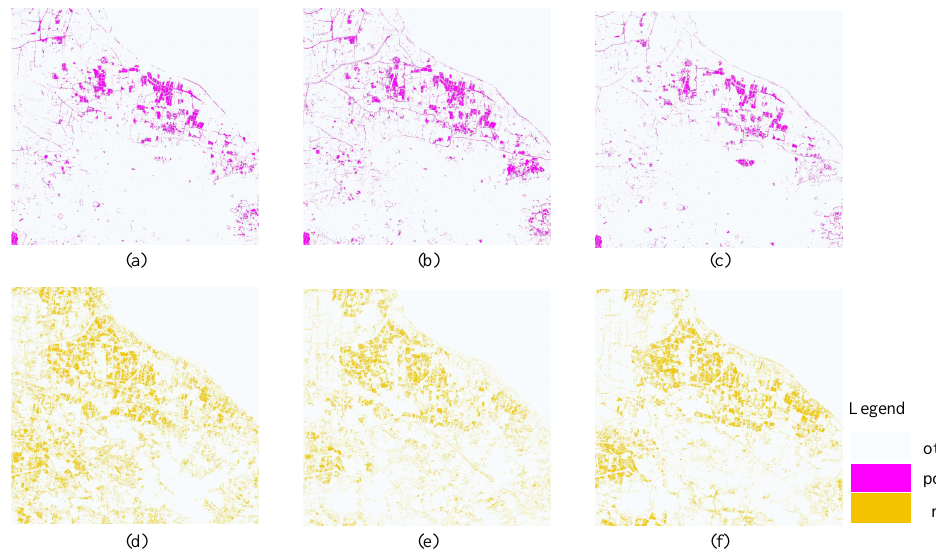
Figure 12. Spatial distribution of ponds in the three images: ( a ) 2018, ( b ) 2020, and ( c ) 2022; spatial distributions of rice in the three images: ( d ) 2018, ( e ) 2020, and ( f ) 2022.